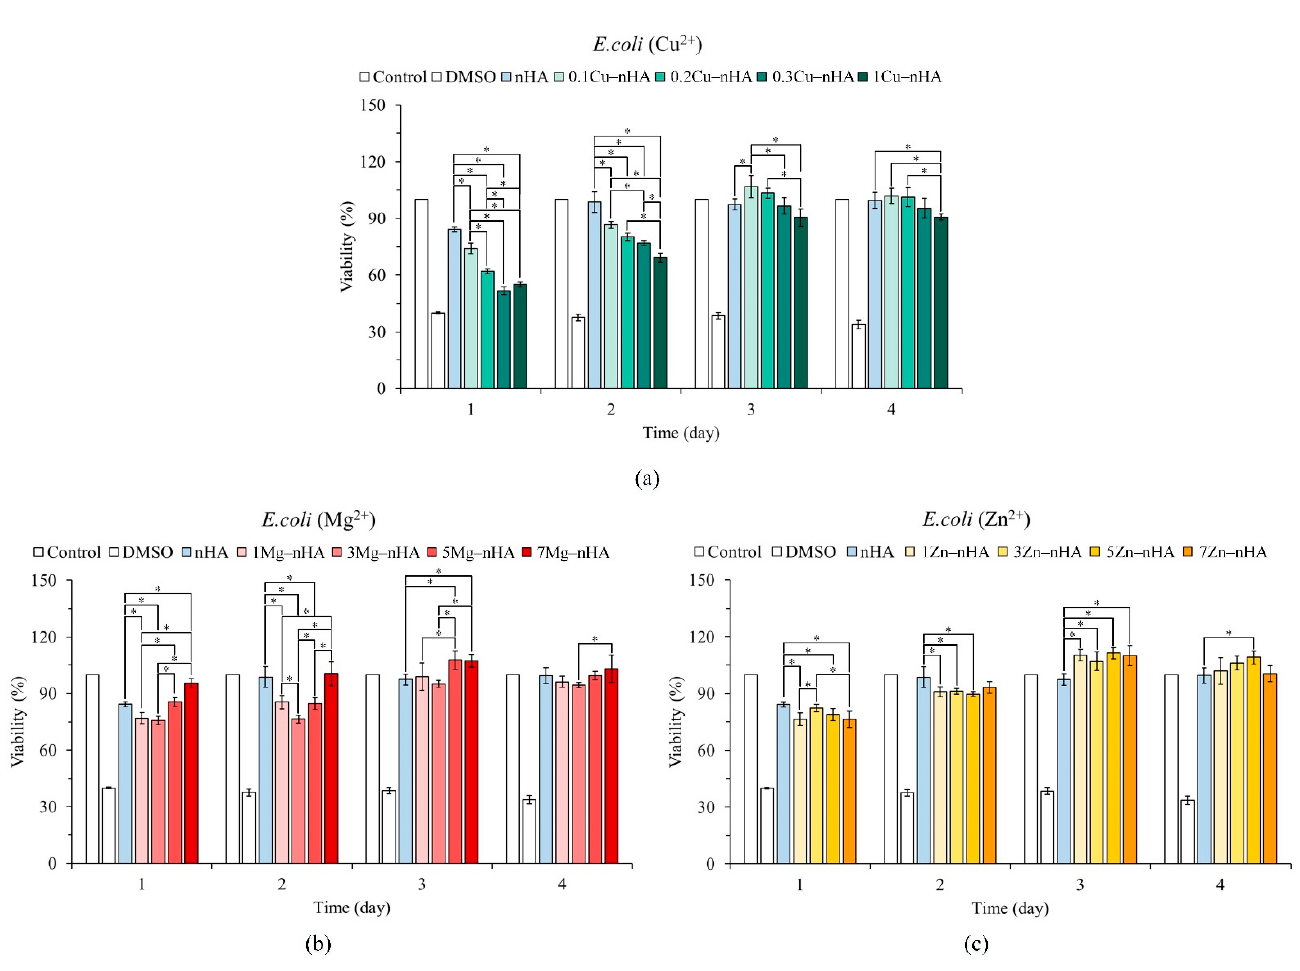
Figure 5. Relative quantitative antibacterial ability against gram-negative E. coli in the presence of different ionic concentrations of Cu 2+ ( a ), Mg 2+ ( b ), and Zn 2+ ( c ), the rod-shaped nanoapatites with different ion concentrations ( n = 3; * p < 0.05).